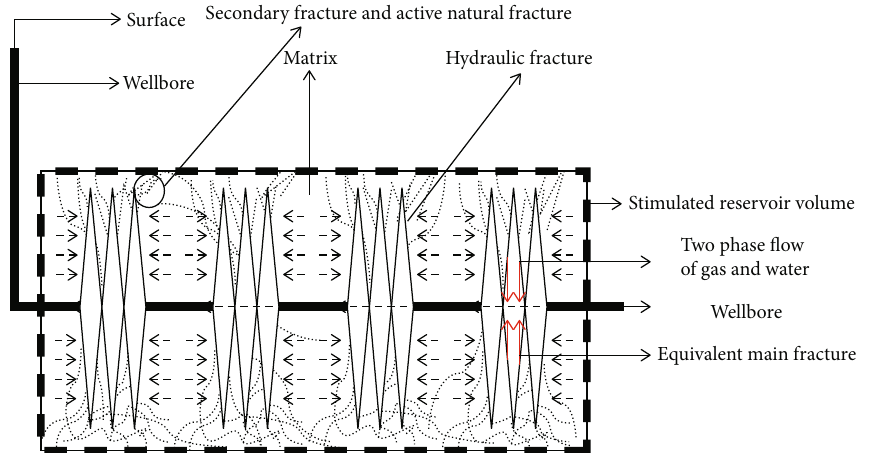
Figure 4: Schematic diagram of the horizontal well with multistage hydraulic fracturing for the development of material balance equation. Dashed arrows show fl uid fl ow direction, which is sequentially from the matrix to fractures and fractures to the